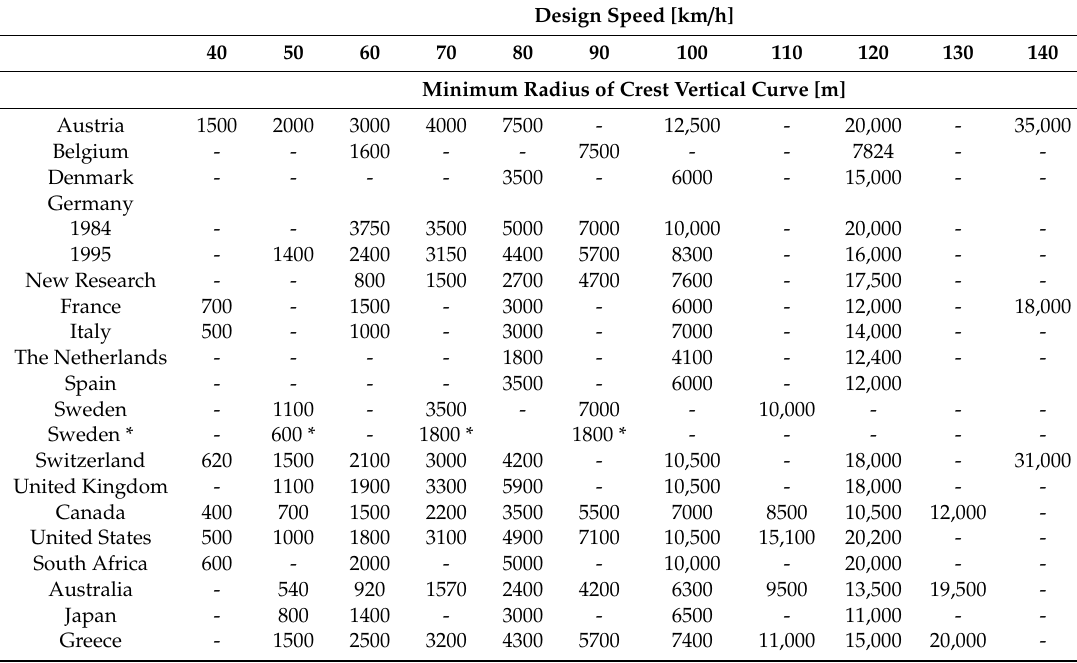
Table 1. Minimum radii of crest vertical curves as a function of design speed in various countries (source